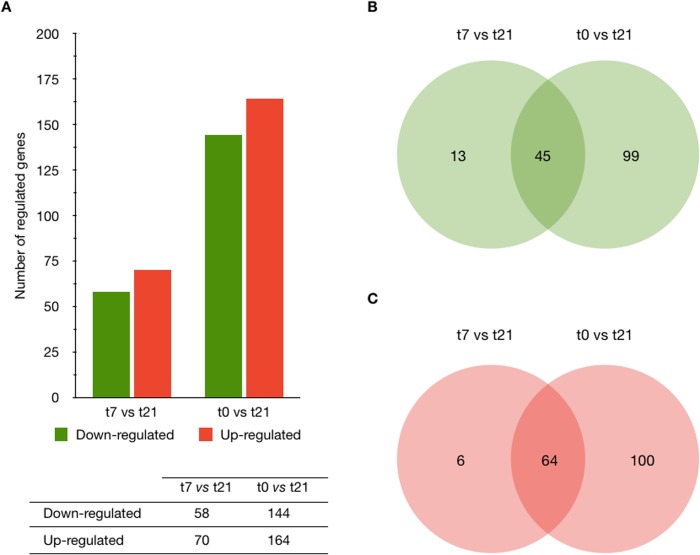
The number of genes differentially expressed as a result of infection with F. hepatica metacercariae.(A) A Venn diagram representing the differentially expressed genes obtained from statistical analyses of two groups (t7 vs t21 and t0 vs t21; Significant Analysis of Microarrays SAM test, false discovery rate at 5%). The figure represents the numbers of probe sets that are differently expressed between the three groups (untreated controls t0, infected and sacrificed at 7 days p.i (t7), and infected and sacrificed at 21 days p.i (t21)) and shared among the analyses (t7 vs t21, and t0 vs t21). (B) Down-regulated genes. (C) Up-regulated genes. Down-regulated genes are represented as green bars and up-regulated genes as red bars.